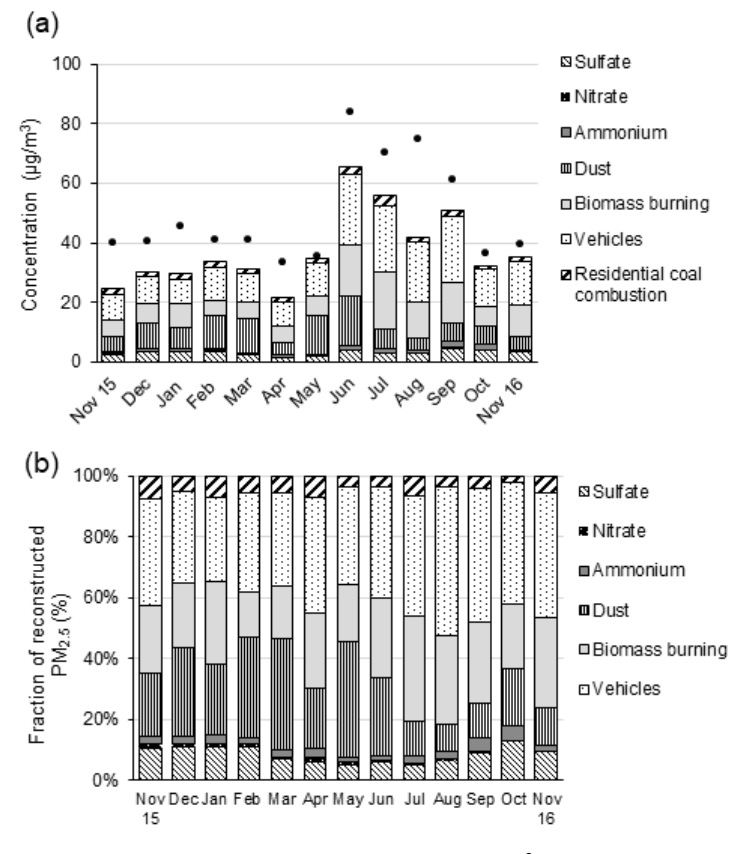
Figure 3. PM 2.5 mass sources in units of ( a ) µ g m − 3 and ( b ) percent of reconstructed (measured/ apportioned) PM mass. Fuel oil is not shown due to small